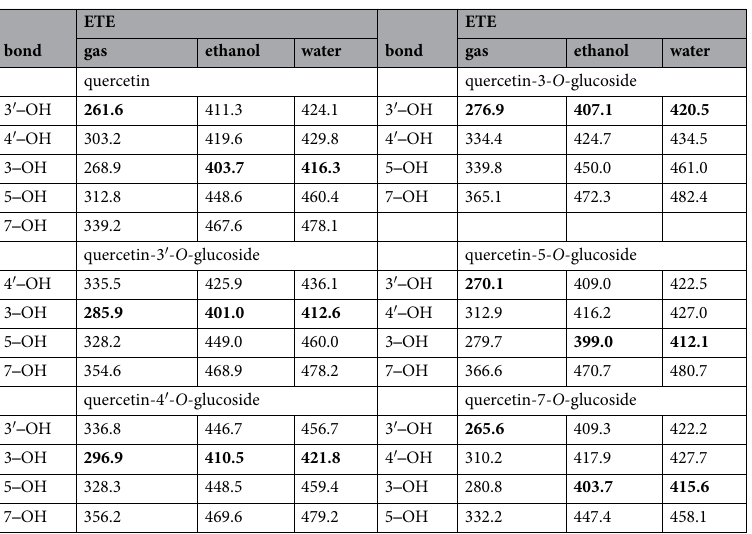
Table 6. Electron transfer enthalpies (ETE) in kJ/mol obtained at M062X/6–311 + G ** level of